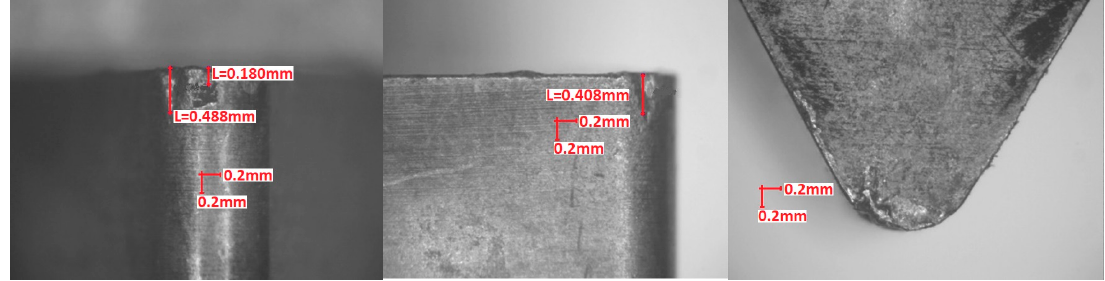
Figure 11. Yttrium implanted at dose 2 × 10 17 ion/cm 2 TNGA 160408E (IS9) edge after turning test ( VB N = 0.4 mm, VB C = 0.2 mm).